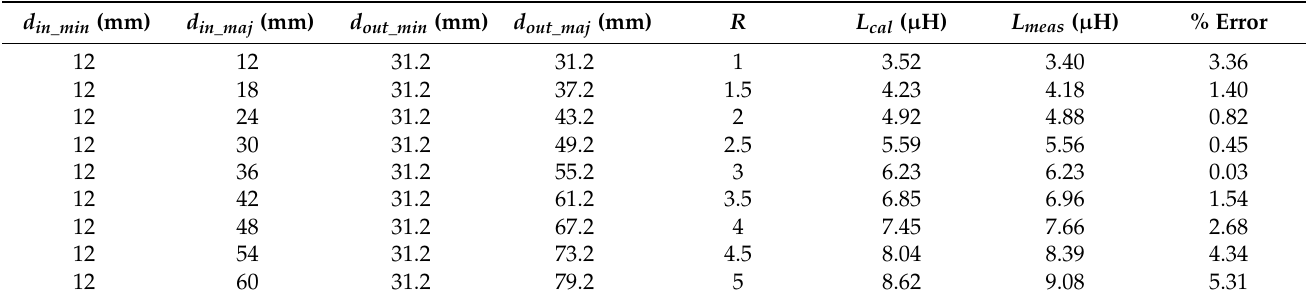
Table 12. Key results of elliptical planar inductors for varying major-to-minor ratios when trace separation ( S ) and trace width ( W ) were kept constant at 400 µ m.